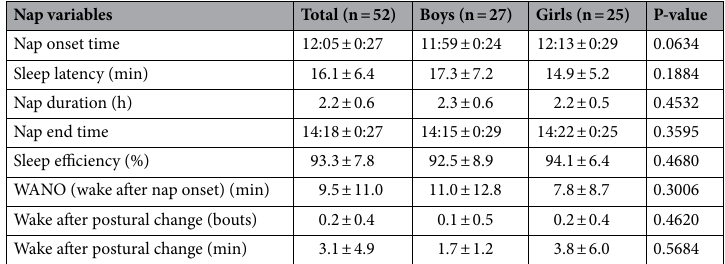
Table 2. Daytime nap variables by sex (mean ± SD).